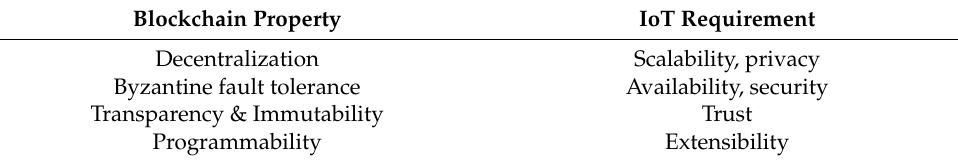
Table 5. How blockchain benefits